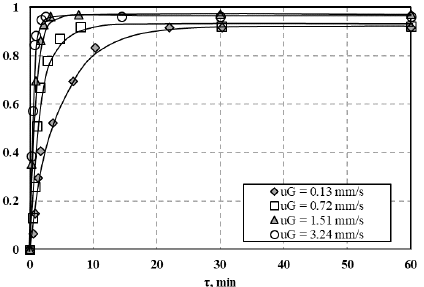
Figure A24. Changes in Zn(II) temporary removal ratio during precipitate flotation from solution containing Al(III), Cu(II), and Zn(II) mixture—effect of air velocity (c 0 = 0.15 mmol dm − 3 , pH = 8.0, c SDS = 0.125 mmol dm − 3 ).